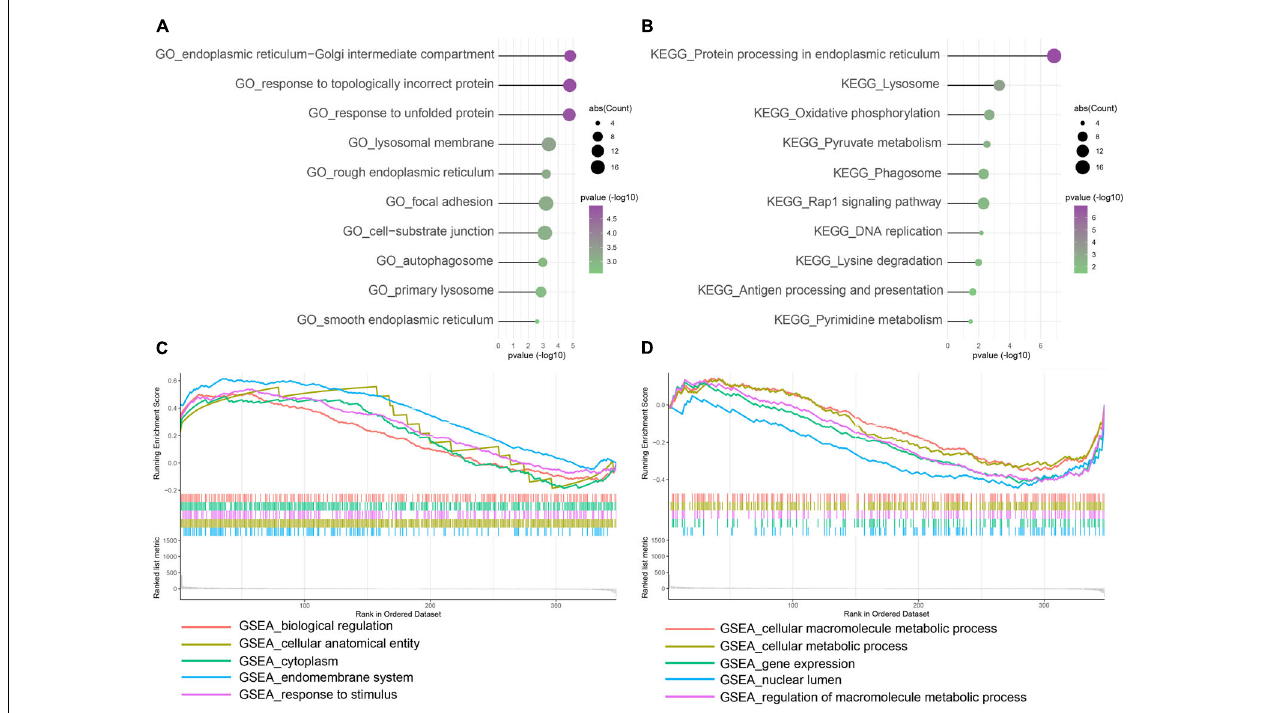
FIGURE 3 | Function enrichment of intersected DEGs between the training and control group. (A) Gene Ontology (GO) enrichment analysis. (B) Kyoto Encyclopedia of Genes and Genomes (KEGG) enrichment analysis. (C,D) Gene Set Enrichment Analysis (GSEA). Enrichment showed that DEG function mainly focused on ERS, unfolded protein response (UPR), autophagy, immune/inflammation, and